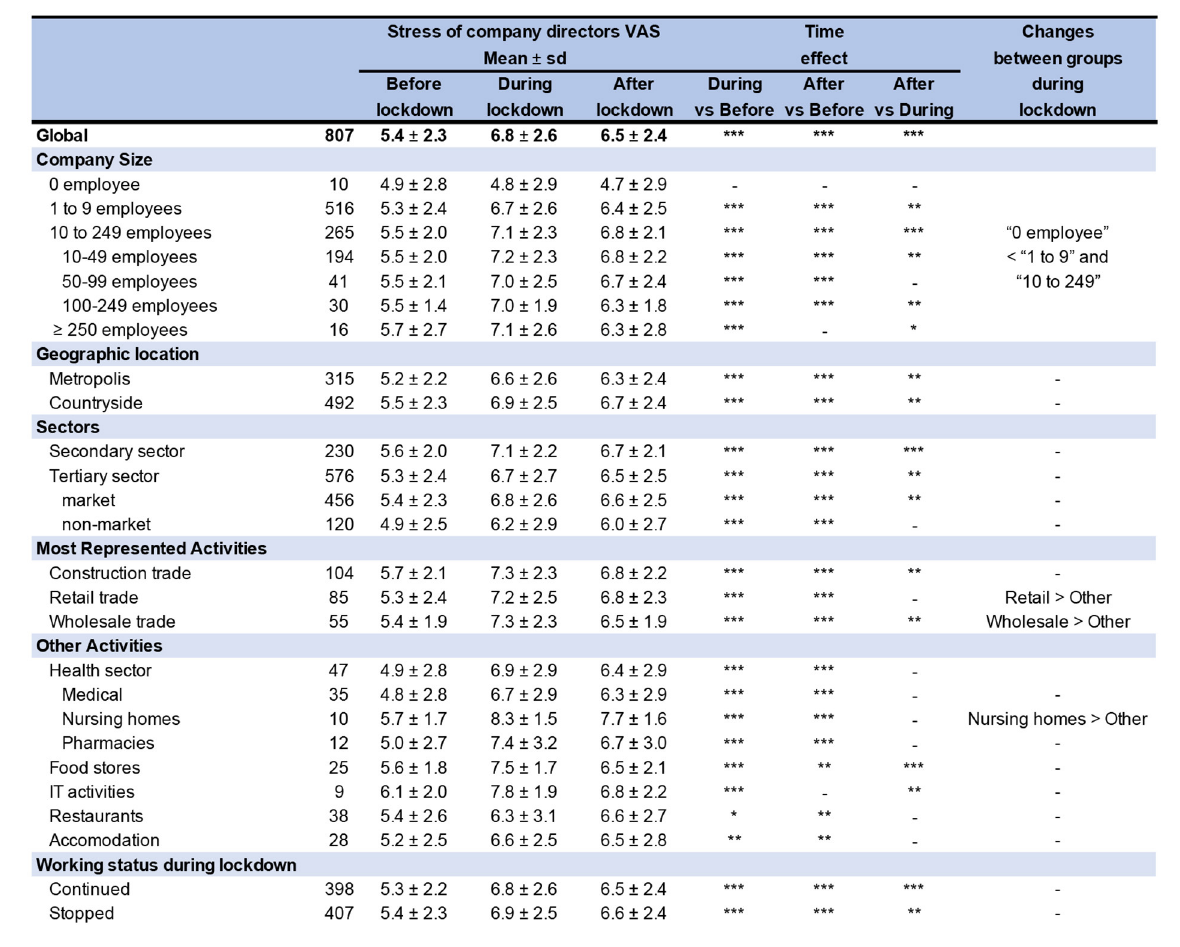
FIGURE2 Stress of company directors. VAS, Visual Analog Scale; SD, Standard Deviation. *** p < 0.001. ** p < 0.01. * p < 0.05. -: non